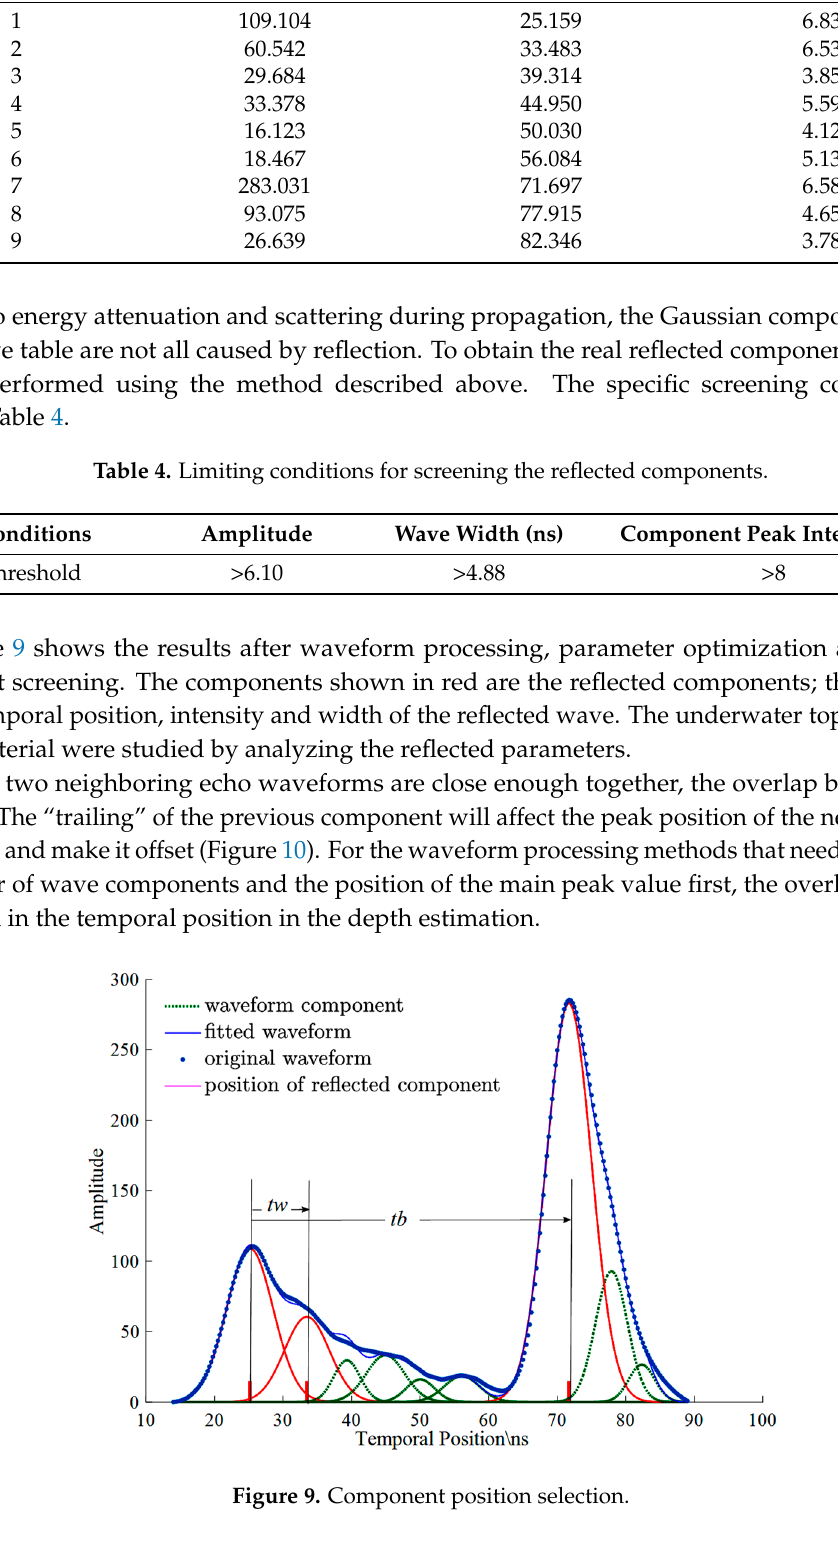
Figure 10. Shift of peak position caused by overlap. The GHPD method is used to decompose the waveform according to the time sequence of signal reception and selects the reflected components, which can effectively reduce the effect of the peak- position offset. In this section, the echo waveform signal with a depth of 3 m was produced by using the Water LiDAR (Wa-LiD), a waveform simulation tool for LiDAR bathymetry [19,30,31], that the incident angle was 15° and the relative refractive index was 1.333. The simulation waveform isshowed in Figure 11. Figure 11. Simulation waveform.